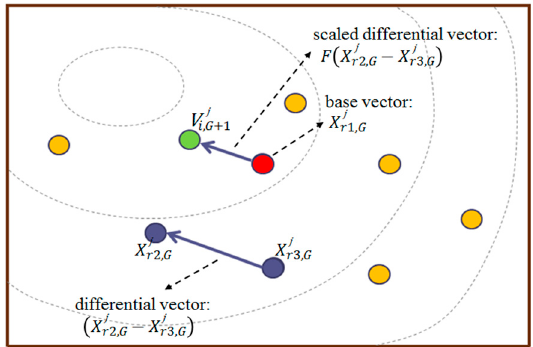
Figure 11. 2D depiction of mutation.